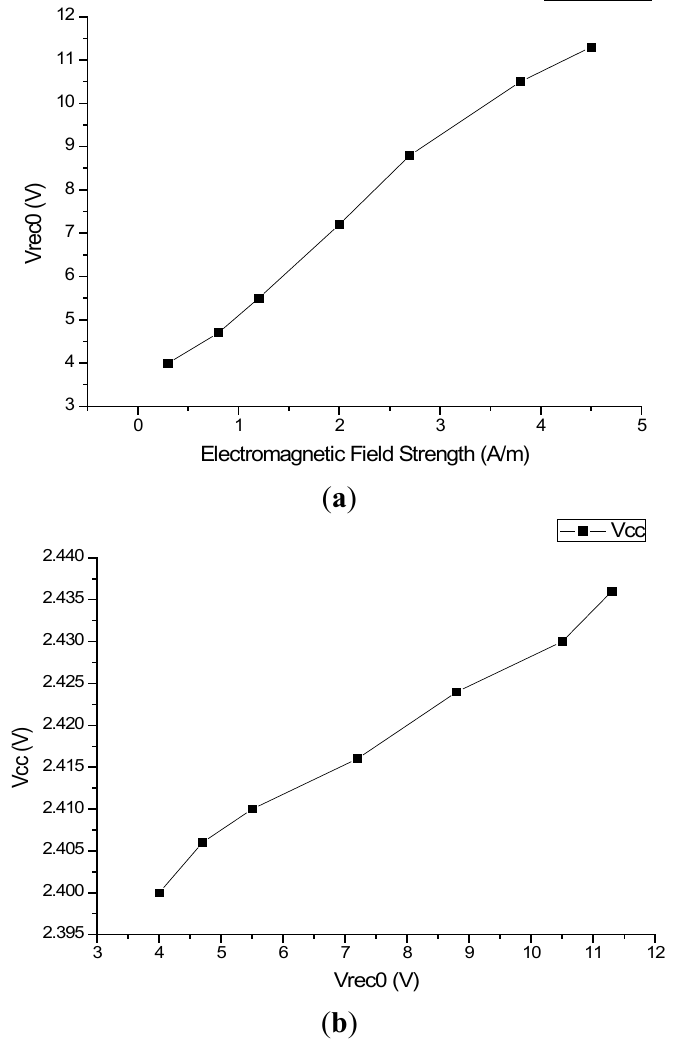
vs . Electromagnetic Field Strength; ( b ) V rec0